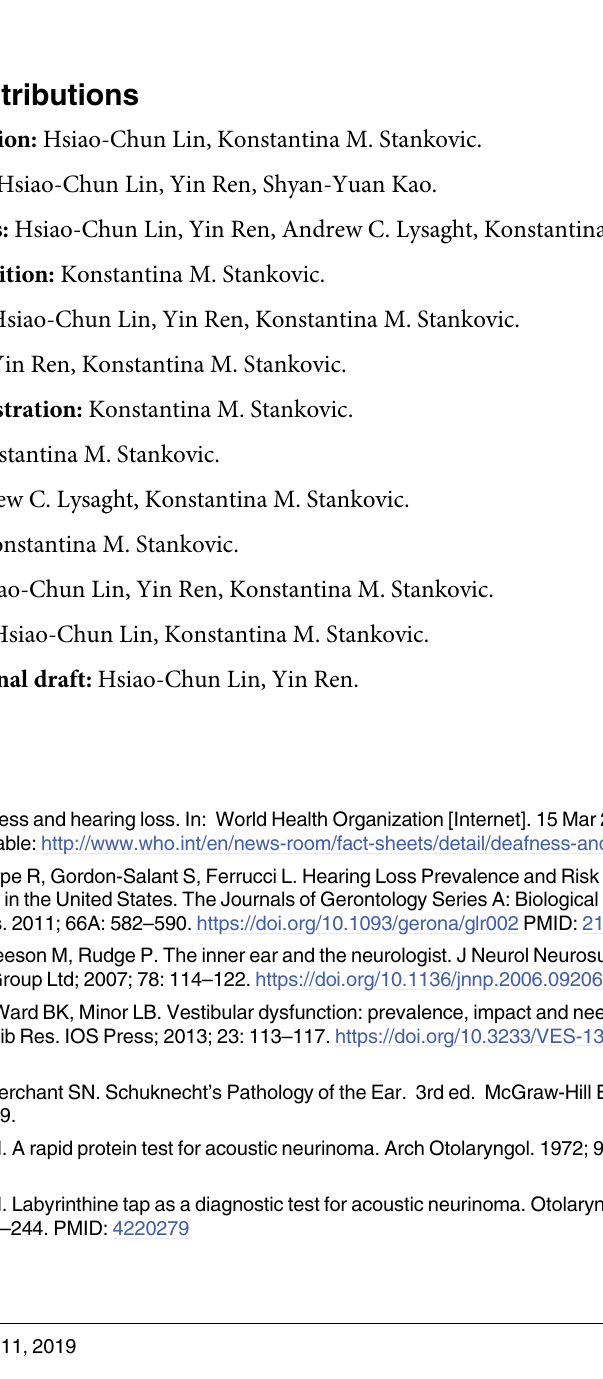
S5 Table. List of 38 proteins summarized in the Venn diagram that are differentially expressed between perilymph of patients with normal hearing and those with seere vestib- ular dysfunction. S6 Table. Spectral counts of all perilymph proteins. S7 Table. Spectral counts of four candidate protein markers in normal perilymph and peri- lymph from patients with severe vestibular